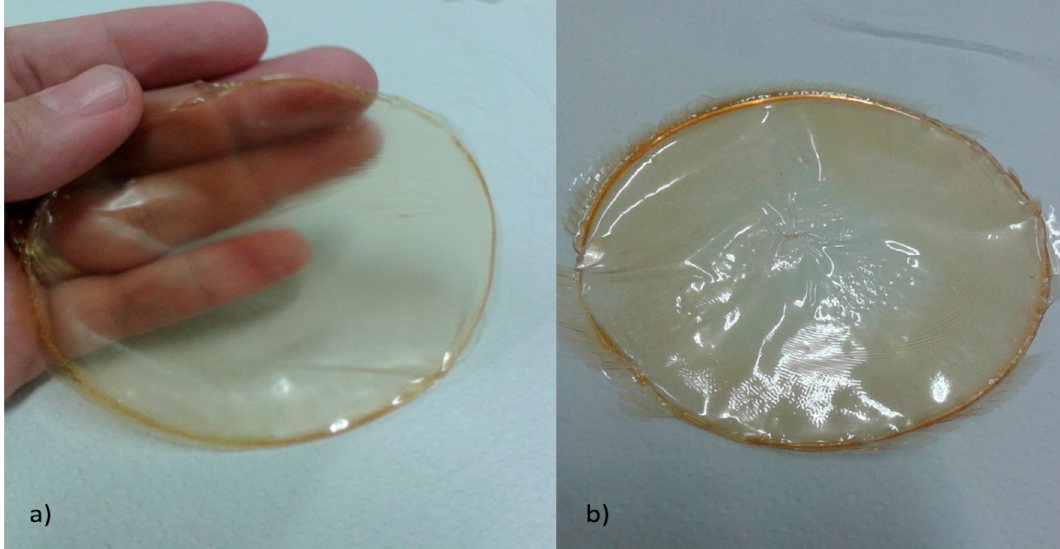
Figure 7. Film sample obtained from collagen of chicken feet with: ( a ) glycerin and ( b ) propylene glycol.